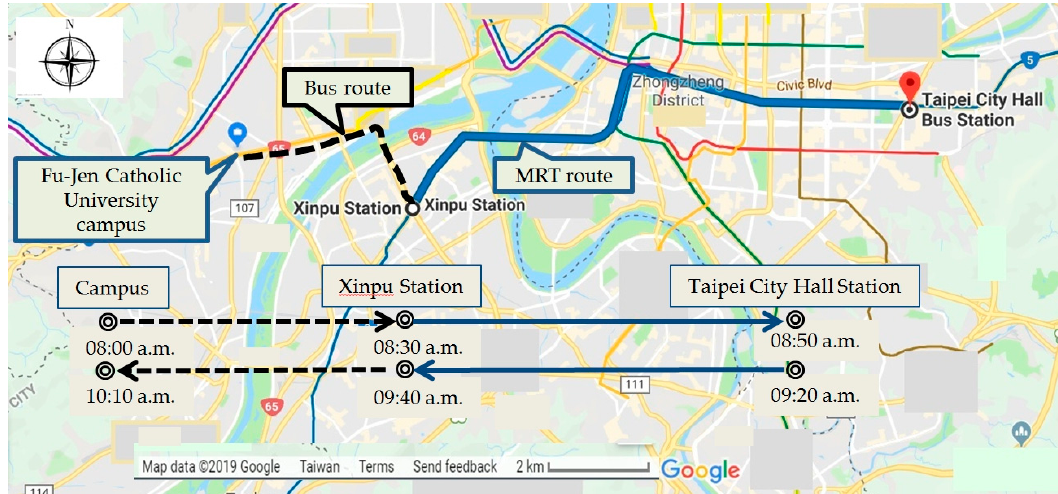
Figure 1. Maps of the different transit routes across Taipei Metropolitan Area. Image taken from Google Maps.